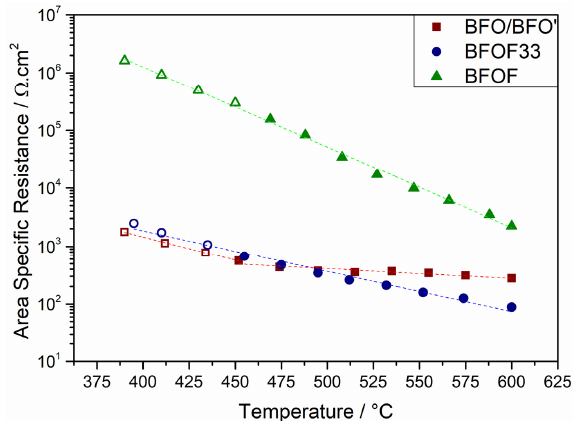
Figure 14. Logarithmic plot of the area specific resistance. Dashed fitting lines highlight the behavior in case of BFOF33 ( ) and BFOF ( ▲ ). BFO/BFO’ ( ) exhibits a bend trajectory. Hollow symbols represent the temperatures with open semicircles.